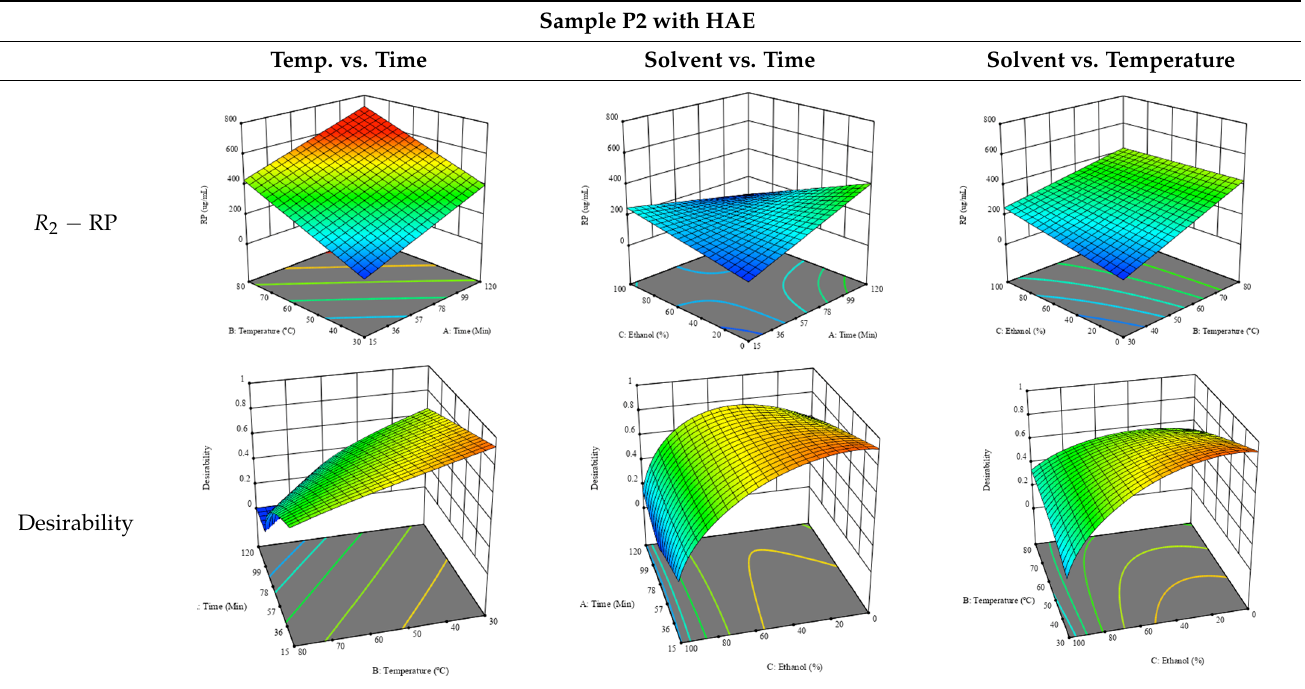
Table 7. Cont. Temp. vs. Time